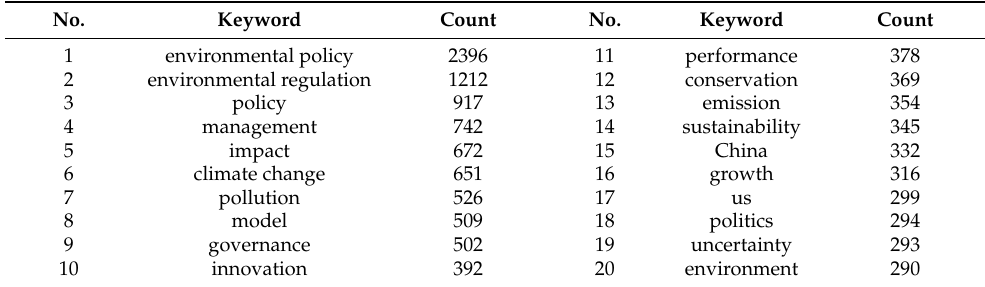
Table 5. Most occurring keywords in research on environmental regulation from 2000 to